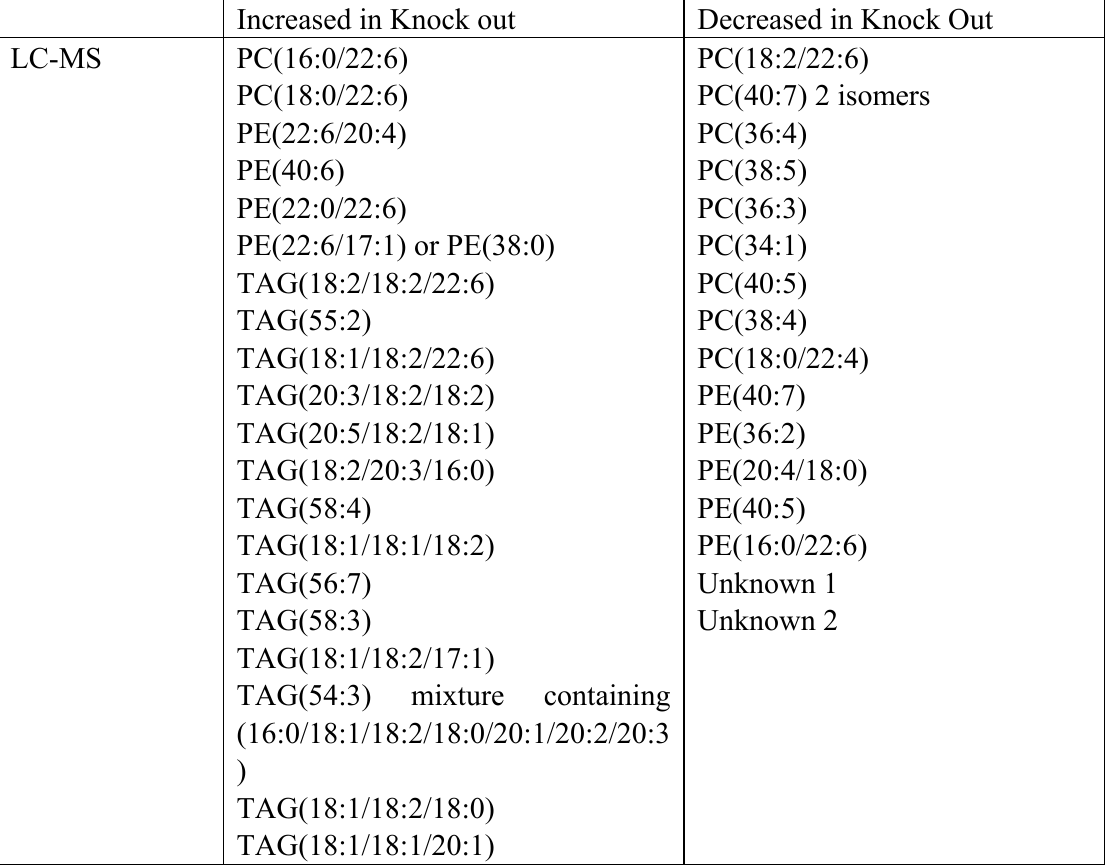
Table 4. Changes in metabolite levels as detected by LC-MS in the combined gender model. Assignments were confirmed by MS/MS. Where individual fatty acids are not specified it was not possible to definitively identify the lipid beyond head group, total chain length and degree of unsaturation. Unknowns 1 and 2 are hydrophobic molecules with a retention time of 7.41 and 6.75 minutes and mass (M+NH 4+ ) of 880.65 and 812.6; both of these unknowns have a fragment ion of 197 Da. Similar changes were detected in the individual gender models. Note it cannot be determined with certainty which fatty acids are in a given position from the fragmentation